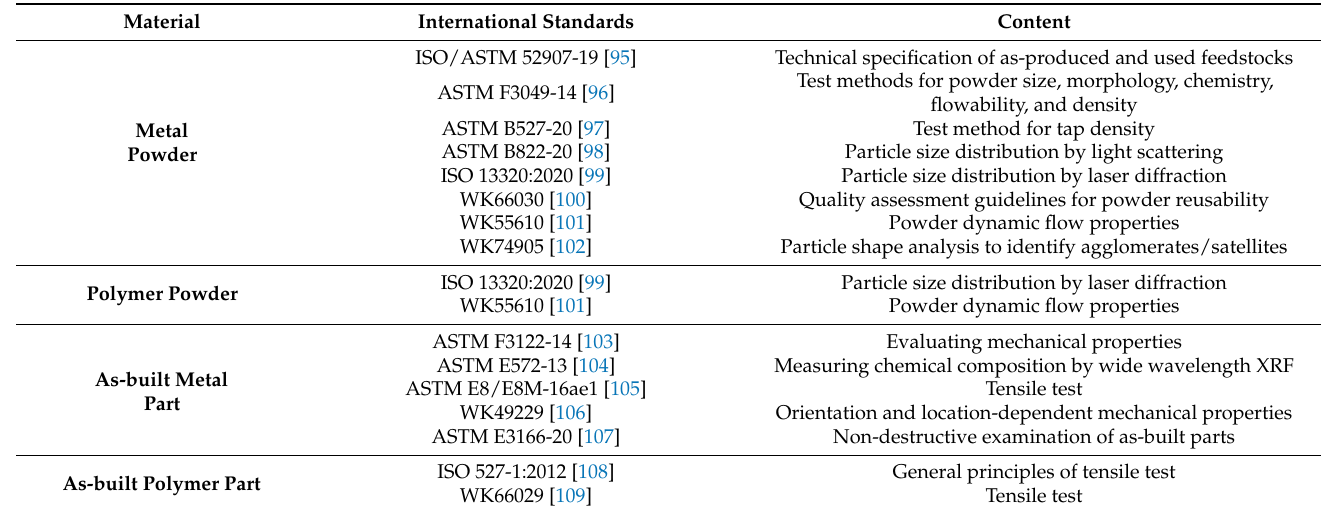
Table 1. Published and developing international standards on the characterization of laser powder bed fusion of metal and polymer powder feedstocks and as-built parts, as basis for the standard operational procedures of the inter-laboratory study.